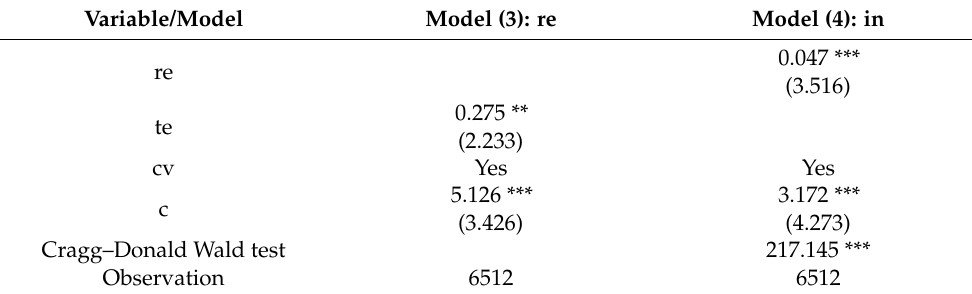
Table 4. Results of robustness